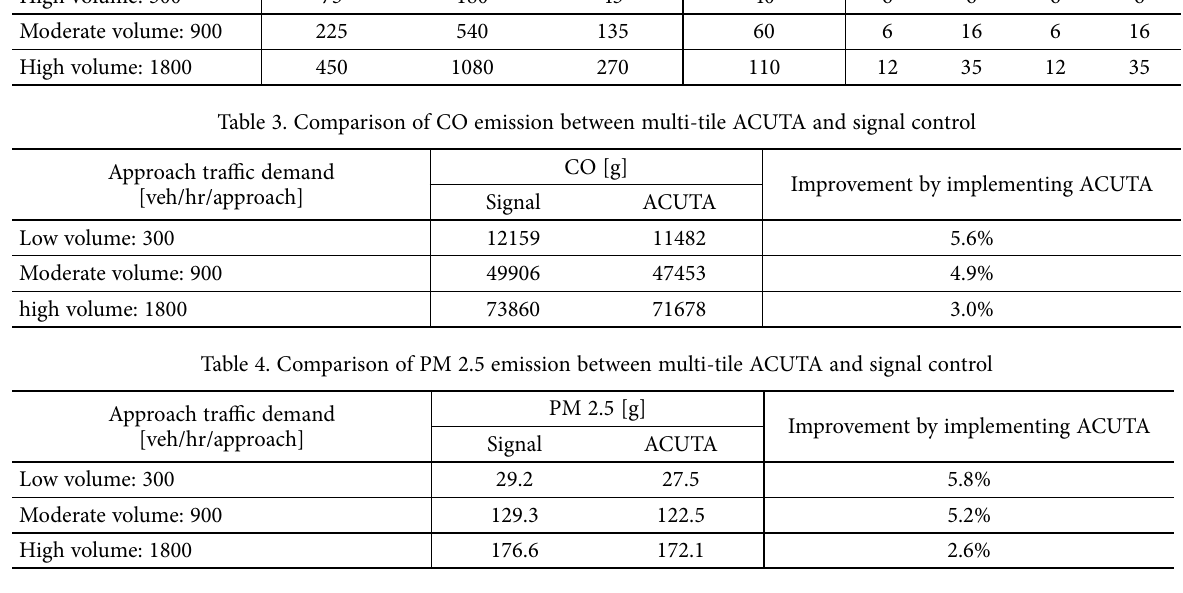
Table 5. Comparison of energy consumption between multi-tile ACUTA and signal